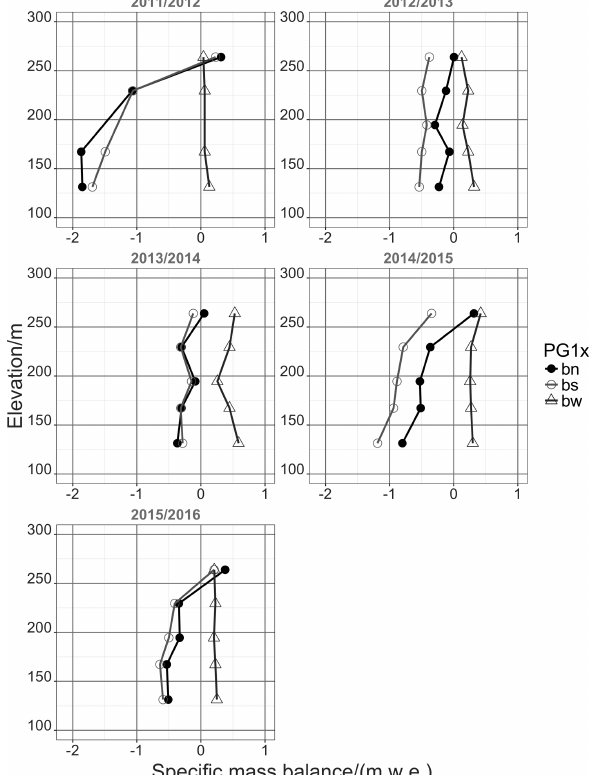
Figure 13. Specific summer, winter and net mass balance ( b s , b w and b n , respectively) in mw.e. derived from mass balance stakes observation at transect PG1 x during 2010 to